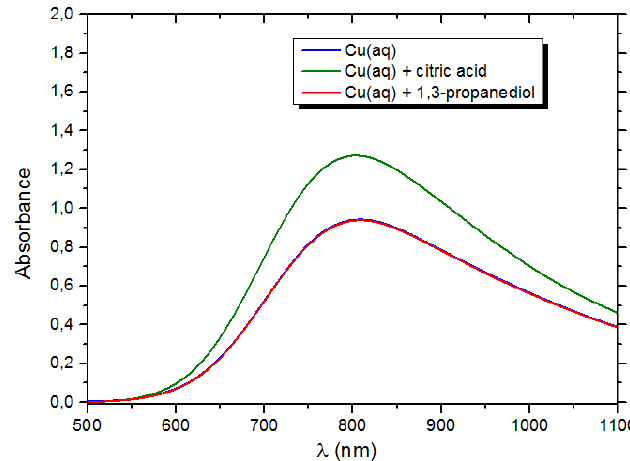
Figure 15. Uv-Vis spectrum of aqueous copper solutions, with and without organic ligands. 1:3 and 1:2 metal-to-ligand molar ratios were used for 1,3-propanediol and citric acid, respectively.